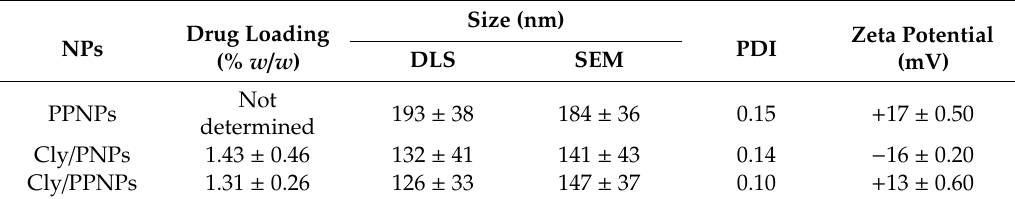
Figure 1. Fabrication of surface charged clindamycin NPs (Cly/PNPs and Cly/PPNPs). Table 1. Characterization of nanoparticles (NPs). DLS, dynamic light scattering; SEM, scanning electron microscopy; PDI, polydispersity index.